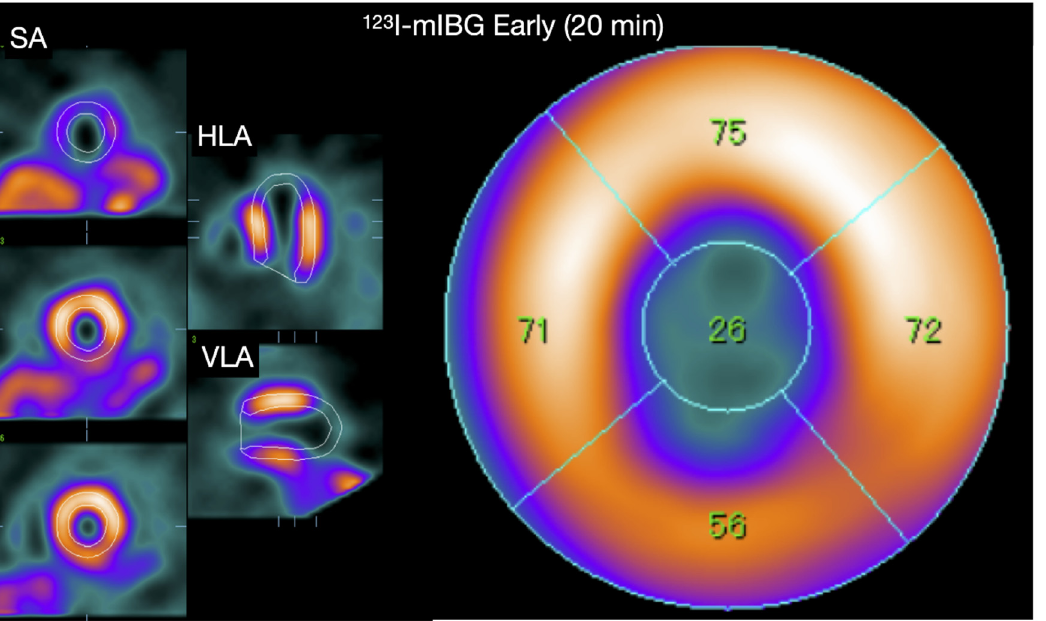
Figure 6. A 60-year-old Japanese woman diagnosed with Takotsubo syndrome. The 123 I m IBG early SPECT show a clear defect in the apical region, and the late image also showed a similar defect (figure not shown). The early and late planar H/M ratio of this patient are shown in Figure 2, show- ing preserved 123 I- m IBG uptake globally despite the severe apical